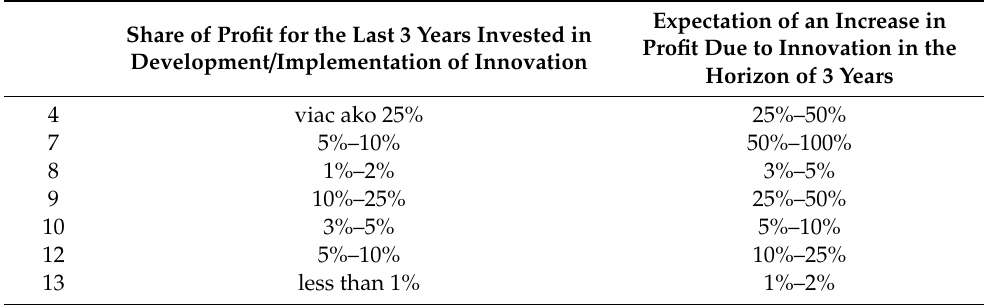
Table 6. An overview of investment in product and service innovation and expectations of profit. Share of Profit for the Last 3 Years Invested in Development / Implementation of Innovation